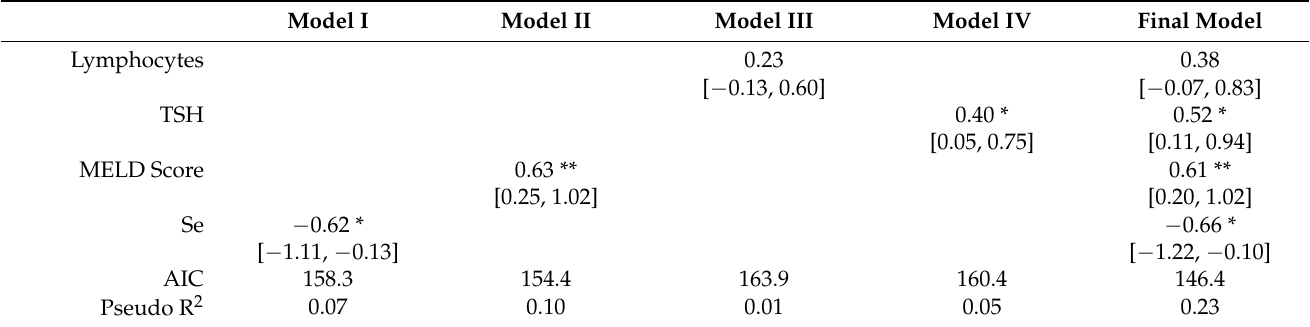
Table 2. Specifics of the predictive models used.